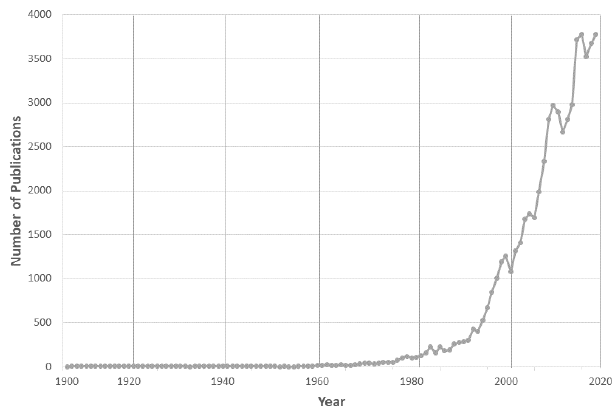
Figure 1. Number of publications per year in a SCOPUS search on the phrase “atmospheric chemistry” (compiled in June